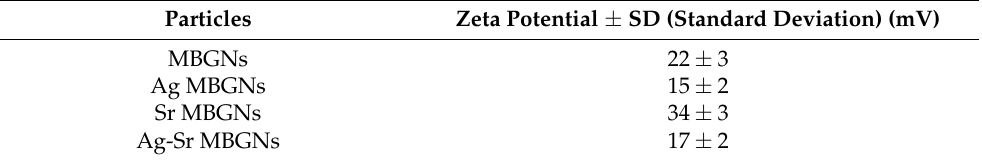
Table 1. Zeta potential measurements for MBGNs, Ag MBGNs, Sr MBGNs, and Ag-Sr MBGNs nanoparticles in pure ethanol.